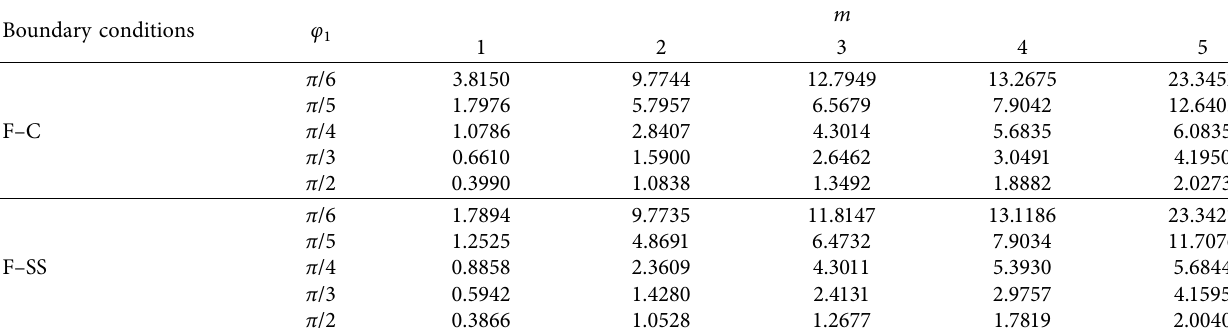
� π /2, R � 1m, h � 0.06m, and n � 2). 1 ( φ 0